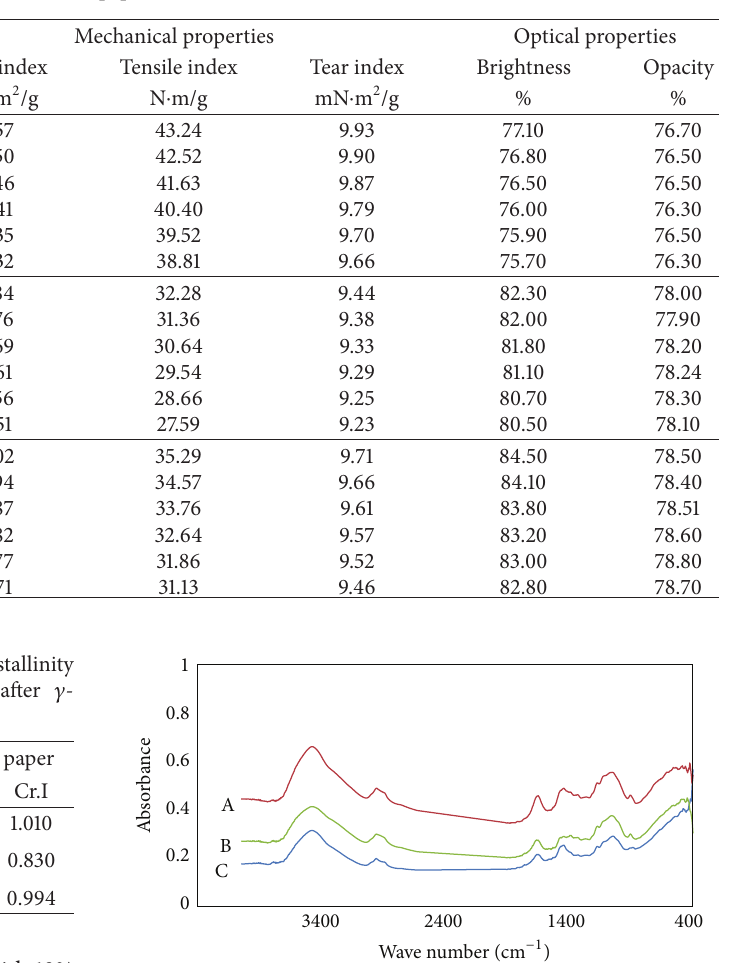
Table 2: Mechanical and optical properties of 𝛾 -irradiation wood paper handsheets: without kaolin, 12% kaolin, and 12% Cs-kaolin.